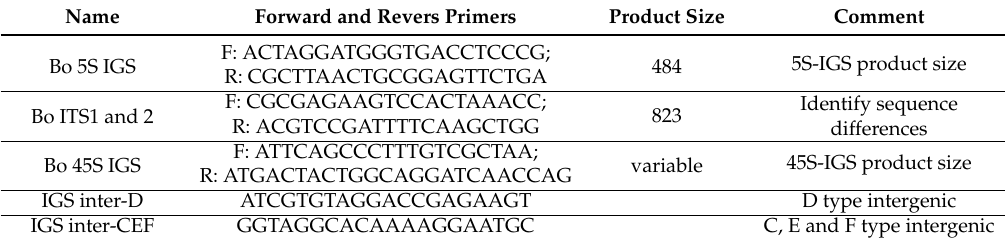
Table 5. Primers designed using Primer3 software to identify 5S and 45S (25S-18S) IGS, ITS1, and ITS2 of B. oleracea var. capitata